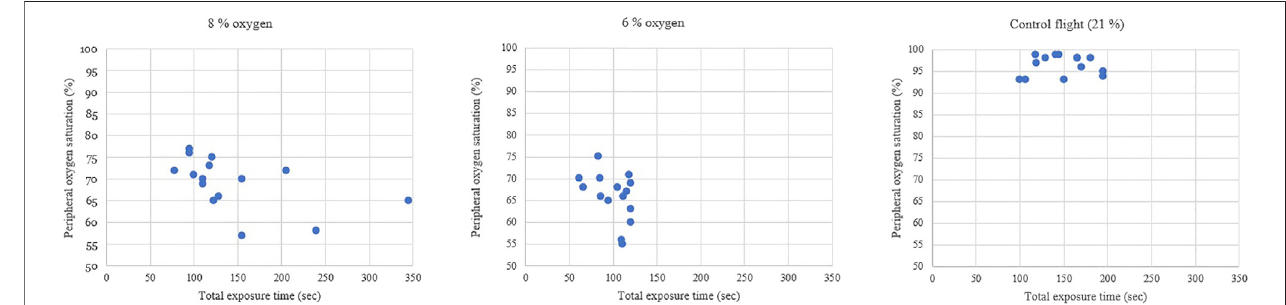
FIGURE 3 | The peripheral oxygen saturation after hypoxia emergency procedures.